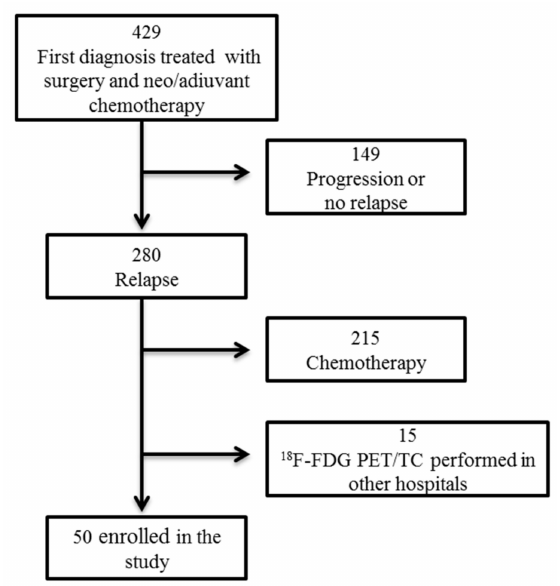
Figure 1. Flow chart of the study. Patient’s selection from our database of patients with ovarian cancer.